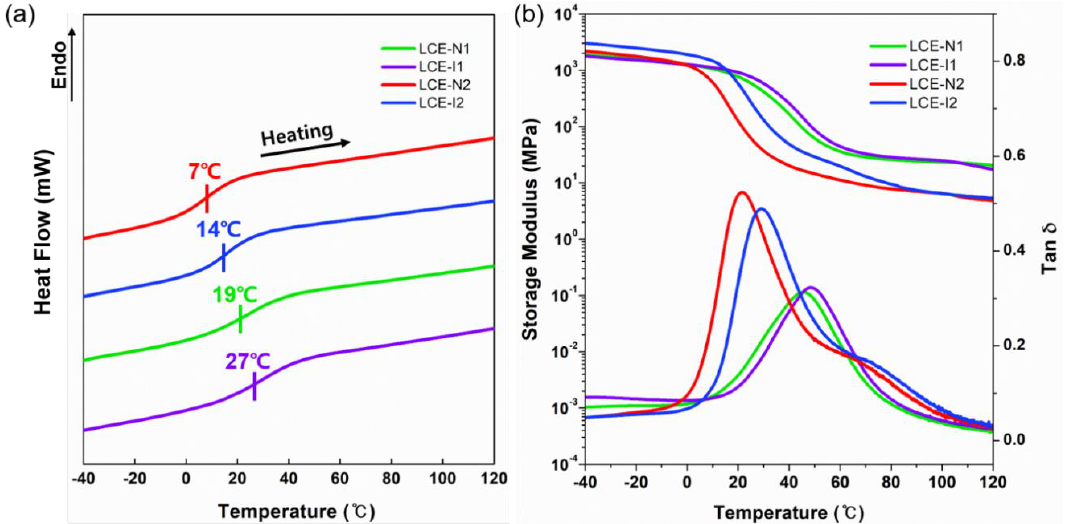
Figure 4. ( a ) DSC thermograms of LCEs during second heating cycle at a heating rate of 10 °C/min. ( b ) Viscoelastic properties of polydomain LCEs .